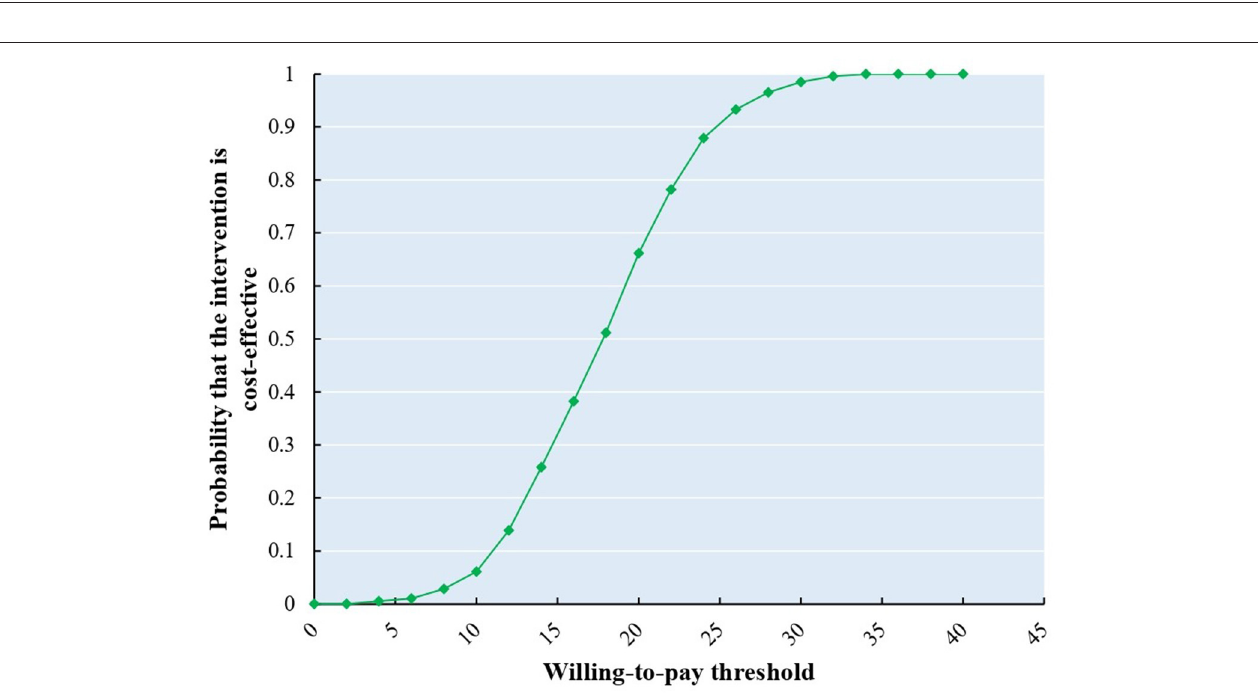
FIGURE 2 | CEAS of reduction in daily methadone dosage.